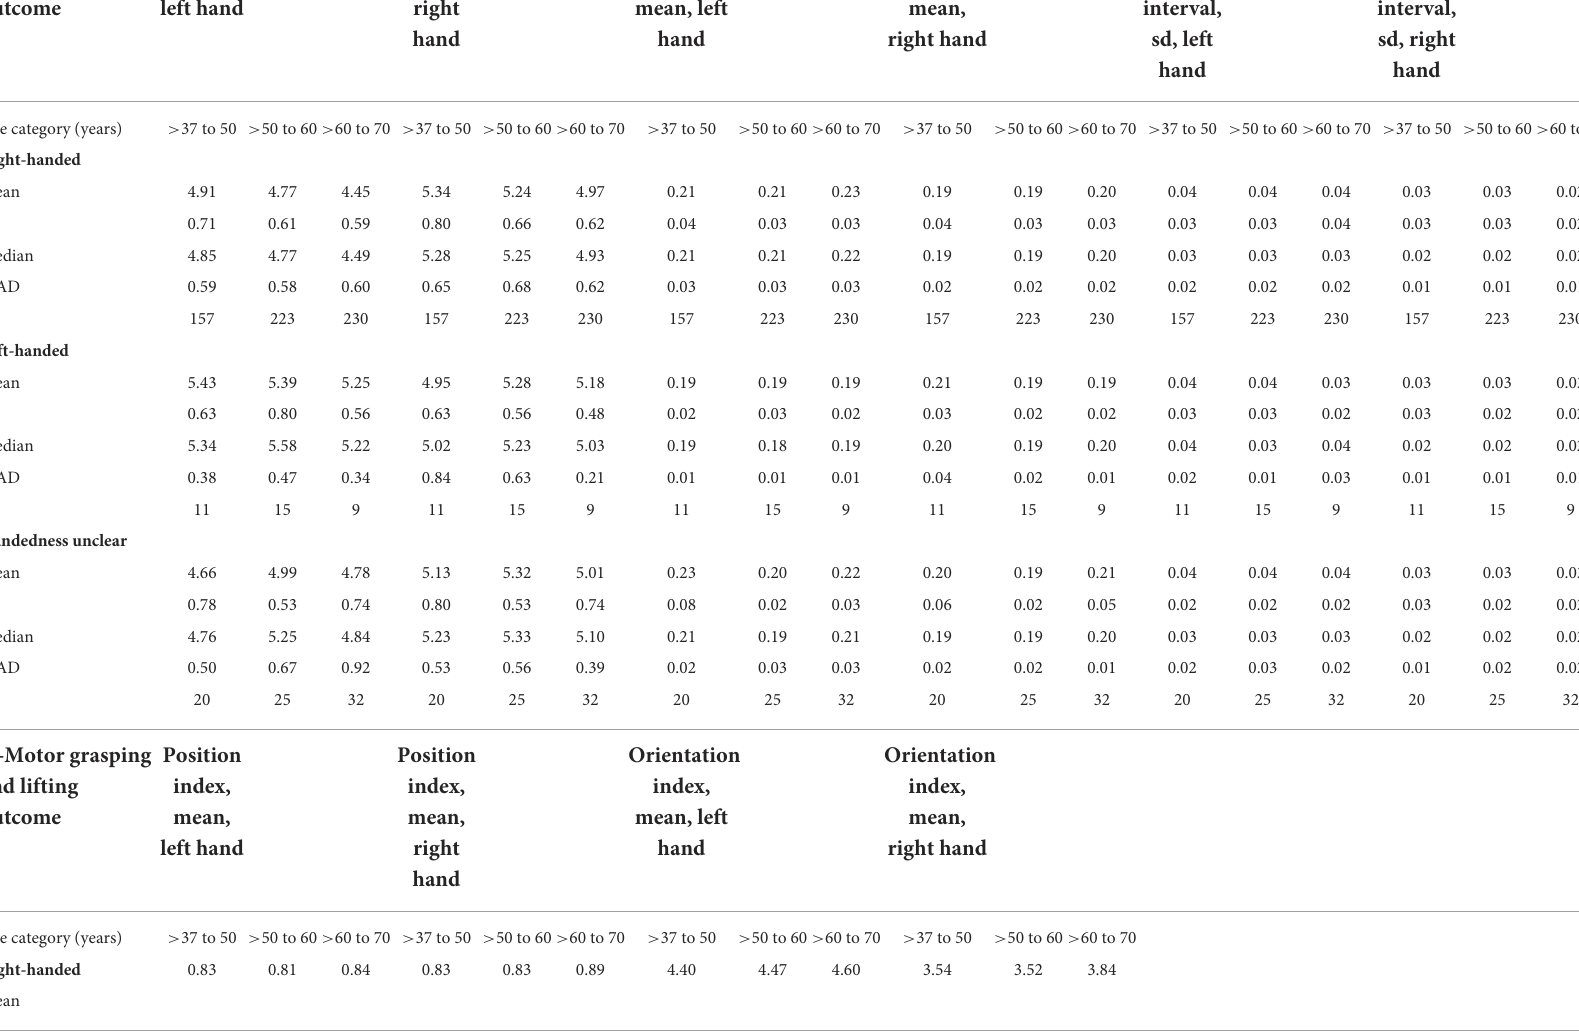
TABLE 3 Measures of central tendency and variability for the (non-transformed) motor outcomes in left and right hands, stratified by test, age category, and handedness. Q-Motor speeded finger tapping